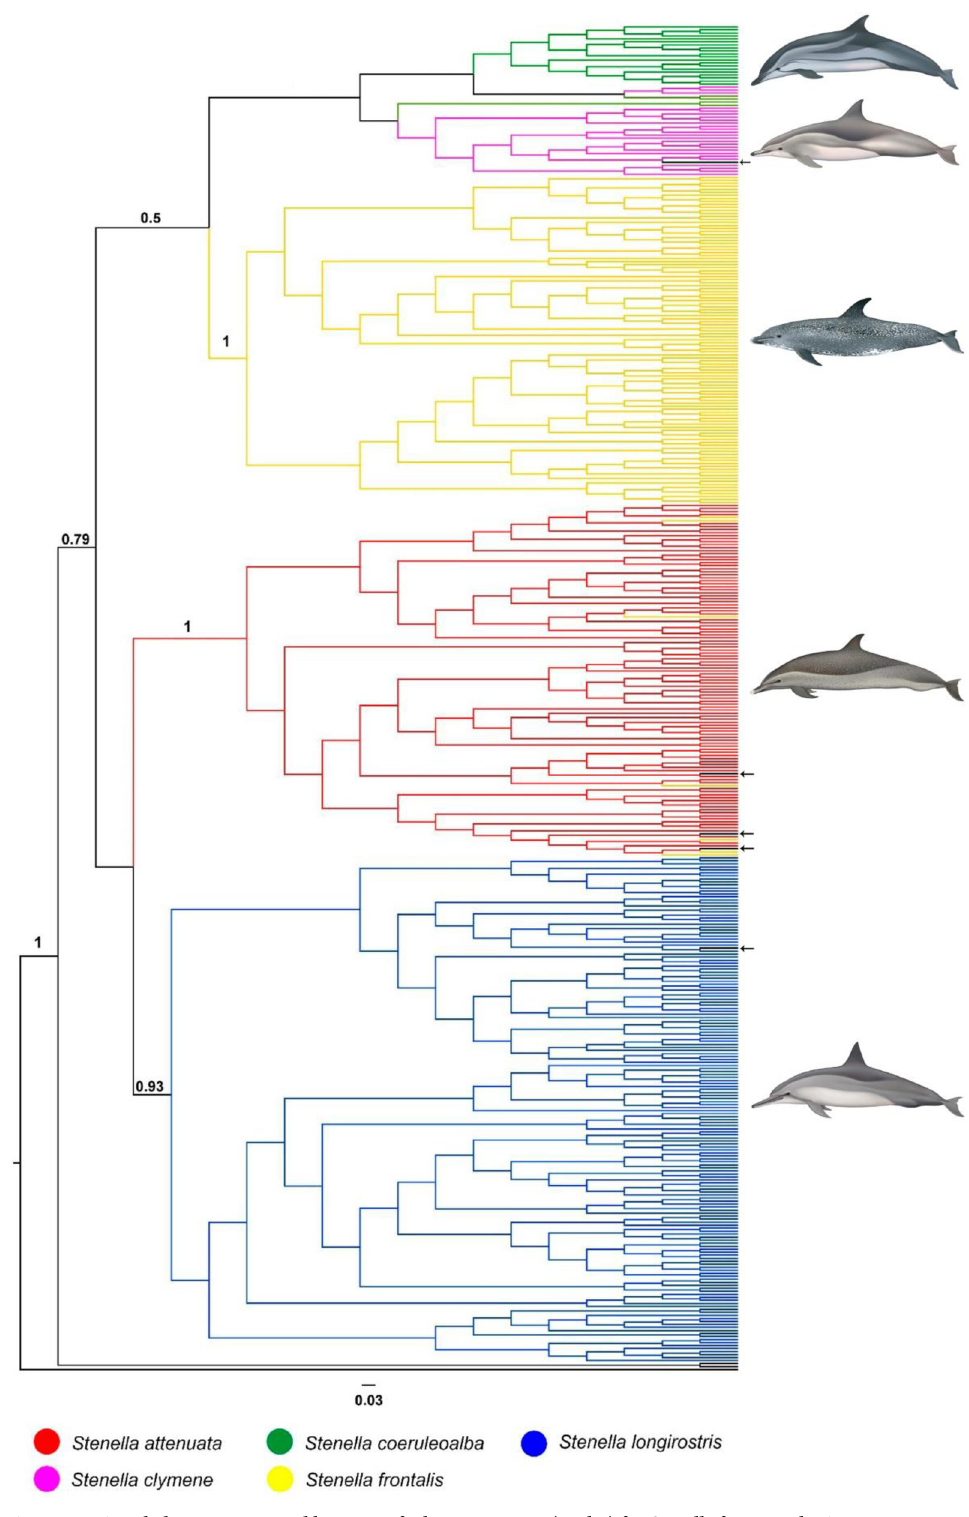
Fig 4. Bayesian cladogram generated by Beast of Dloop sequences (331bp) for Stenella for ocean basins comparisons. Posterior probability values greater than 0.5 are presented above nodes. Black arrows indicate misplaced haplotypes. Dolphins images have been extracted from the website http://cis.whoi.edu/science/B/whalesounds/index.cf.